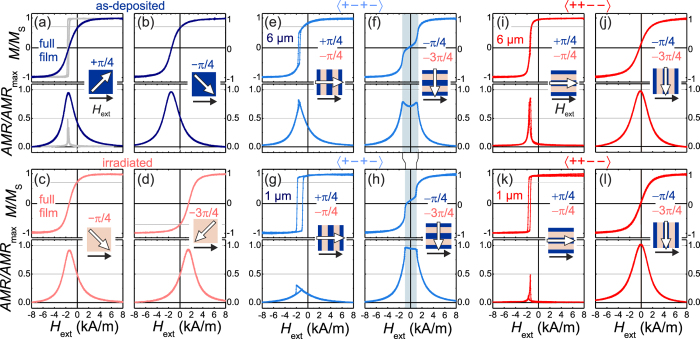
Magnetization curves M(H)/Ms = cos (θ) and corresponding magnetoresistance (AMR) AMR(H)/AMRmax = sin2(θ) response of an as-prepared full film with the magnetic field Hext aligned under an angle of (a) θdep = π/4, and (b) θdep = −π/4 with respect to the initial direction of exchange bias. Corresponding data for an ion irradiated full film with (c) θirr = −π/4 and (d) θirr = −3π/4 relative to the rearranged unidirectional anisotropy (π/4 and −π/4 to the original direction of exchange bias). The data for applying a field along the direction of exchange bias is indicated in (a). Corresponding M(H) and AMR curves for structures with a stripe width of (e,f,i,j) 6 μm and (g,h,k,l) 1 μm, and with (e–h) head-to-tail-to-head-to-tail (〈+ − + −〉) and (i–l) head-to-head-to-tail-to-tail (〈+ + − −〉) unidirectional anisotropy configurations with the magnetic field Hext aligned perpendicular [(e,g,j,l)] and parallel [(f,h,i,k)] to the stripe axis. The magnetic field direction, stripe orientation, and direction of net exchange bias EBnet are sketched. The angles of EBdep and EBirr relative to the direction of Hext are indicated (see also Fig. 1).